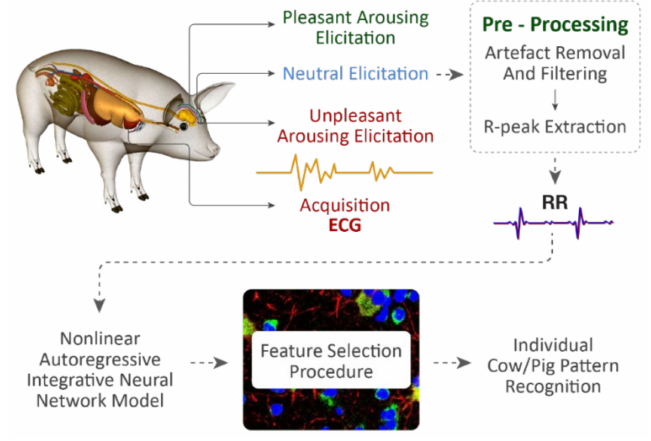
Figure 4. Overview of the farm animal affective measurement experimental set-up and block scheme of heart-rate signal processing and data classification